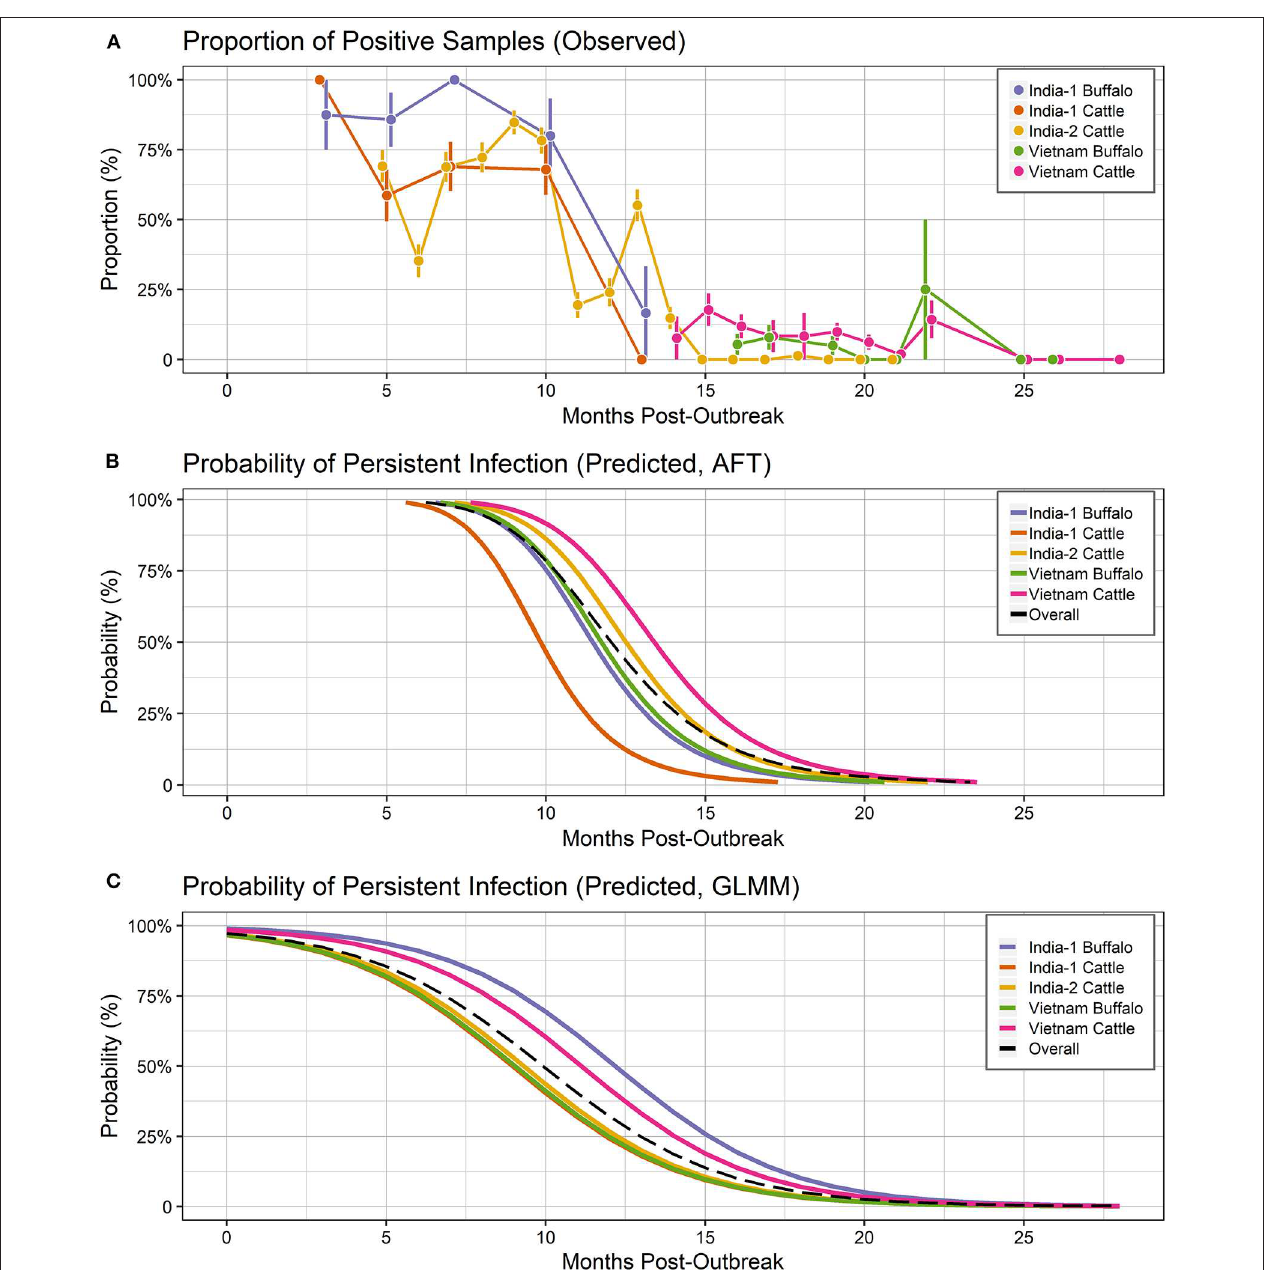
FIGURE 4 | Probability of persistent infection, Vietnam and India data combined. All study animals were seropositive for FMDV anti-NSP antibodies by 3ABC-ELISA (Vietnam) or by r3AB3 I-ELISA (India). (A) Observed proportion of OPF samples positive for FMDV RNA. Mean and standard error are shown. (B) Predicted probability of persistent infection, AFT model. (C) Predicted probability of persistent infection, GLMM